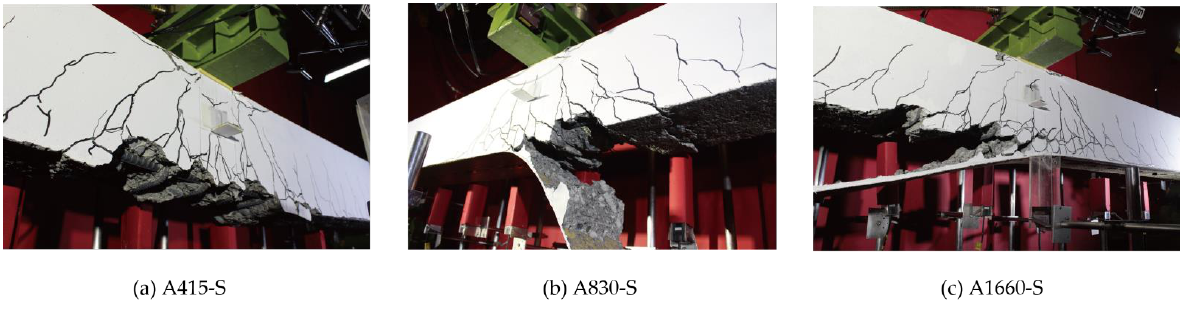
Figure 11. Close-up photo of the debonded sheet together with concrete for the beams.